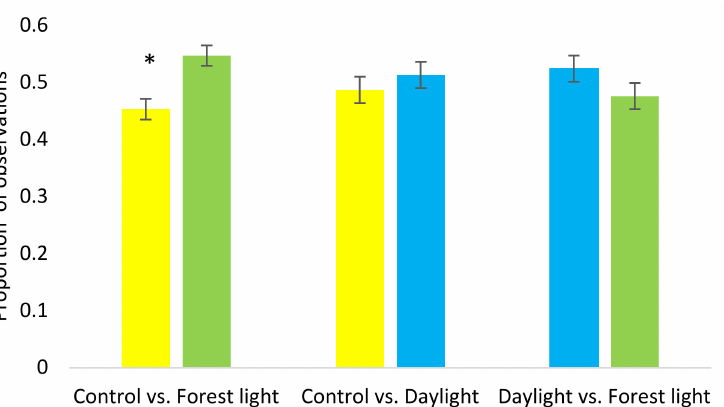
Figure 4. Pairwise comparisons from the preference test of proportion of birds observed in the different sections with different light treatments. Asterisk indicates significant difference ( p < 0.01) between light